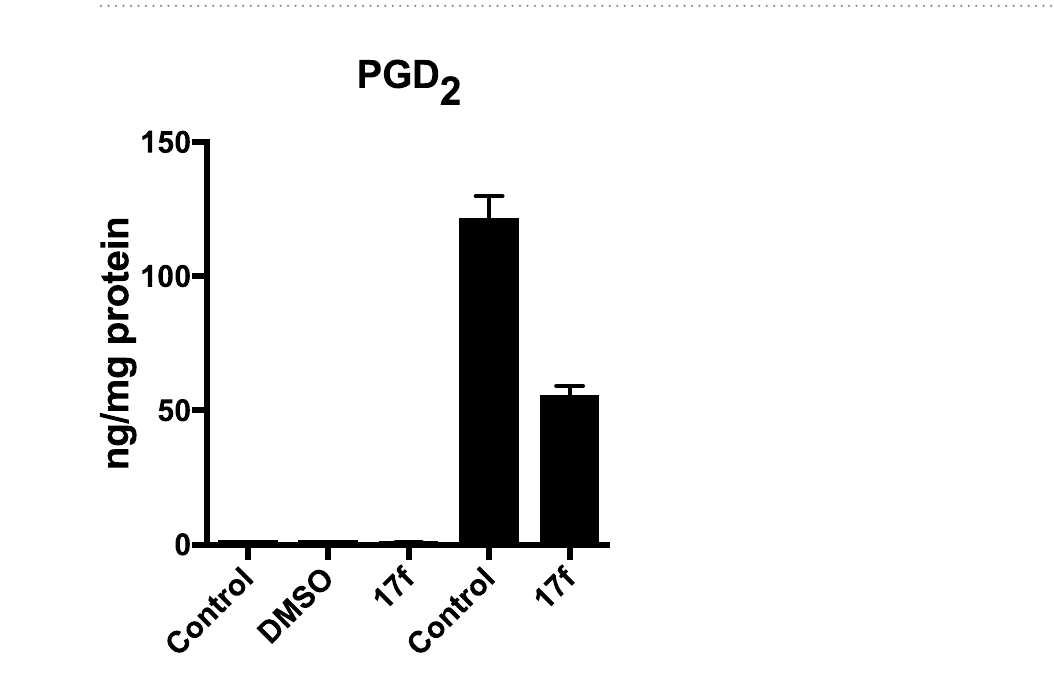
Figure 8. Inhibitor 17f inhibits KLA-elicited prostaglandin D 2 biosynthesis by macrophages. Macrophages were pre-treated with media (control), vehicle control (DMSO, 0.1%) or inhibitor 17f (5 μ M) 1 hr before KLA (100 ng/mL, ■ ) or mock ( □ ) treatment. Supernatants were collected 24 hr following stimulation for eicosanoid quantification. Graph displays the mean ± SEM of a single experiment containing technical duplicates that is representative of 2 independent experiments. * indicates statistical difference compared to KLA treatment (P ≤